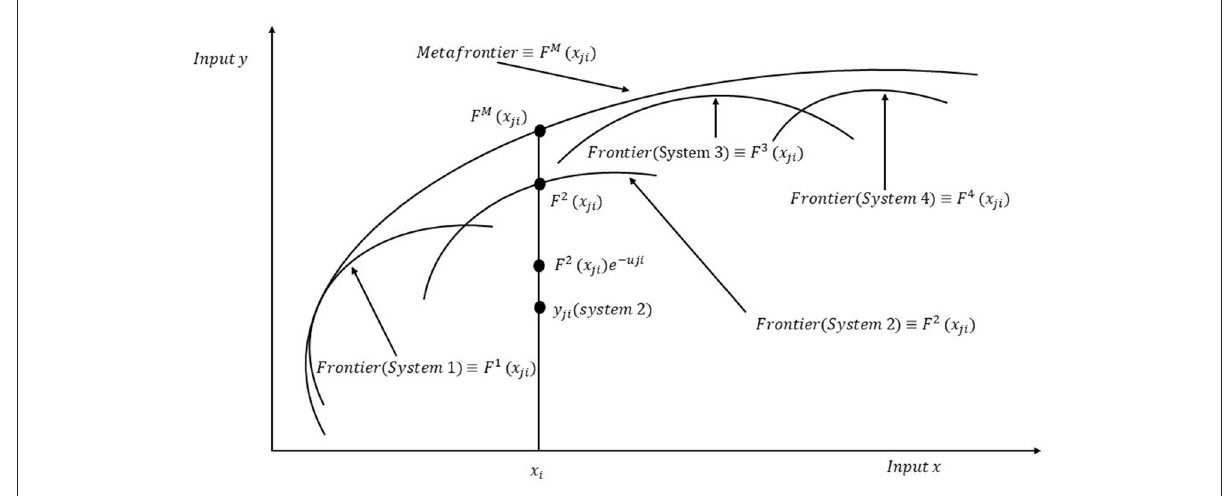
FIGURE2 Concept of a stochastic meta-frontier. Source: Melo-Becerra and Orozco-Gallo